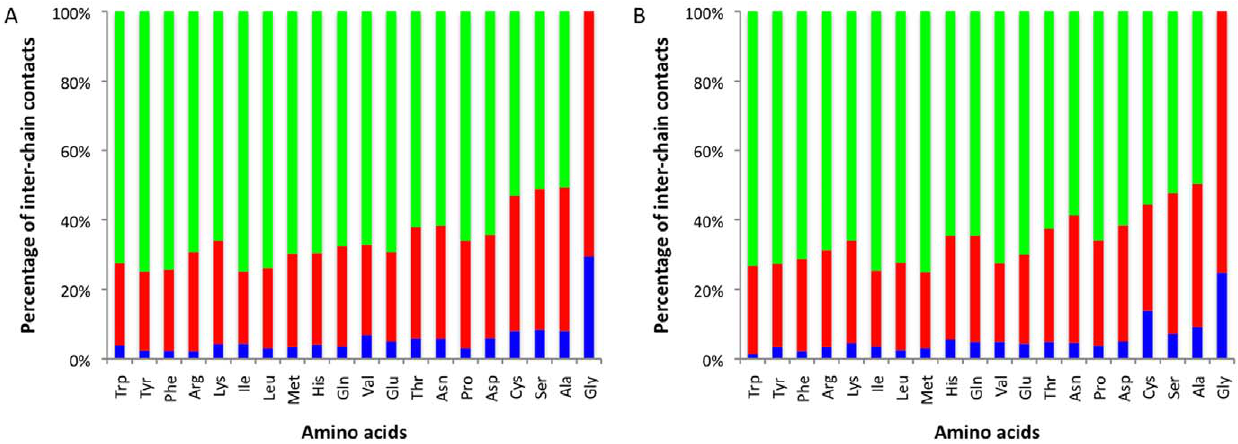
Figure 3. Distribution of inter-chain contacts depending on amino acid type. A. Contacts in homocomplexes. B. Contacts in heterocomplexes. Blue, fraction of main-chain to main-chain contacts. Red, fraction of main-chain to side-chain contact. Green, fraction of side-chain to side-chain contact.1.